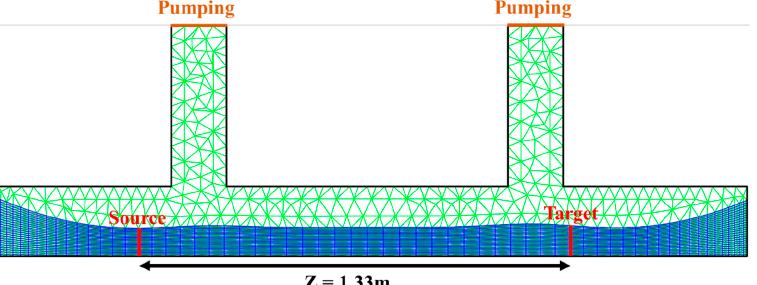
Figure 14. The simulation mesh grid distribution. The source and target positions are selected with a distance of 1.33 m.